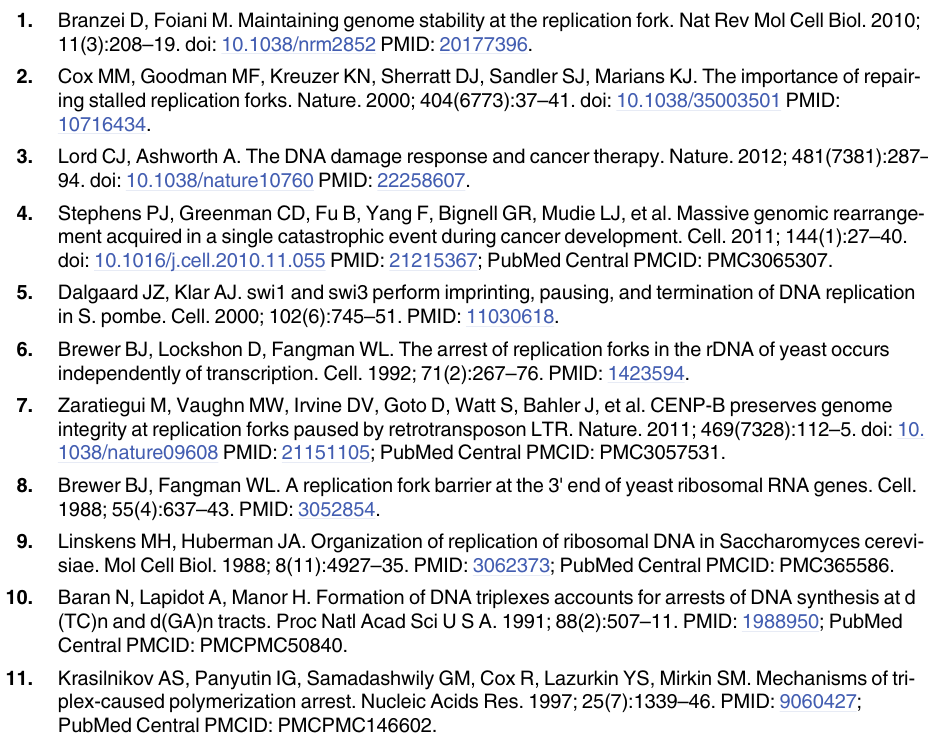
S2 Table. Oligonucleotide primers used in this